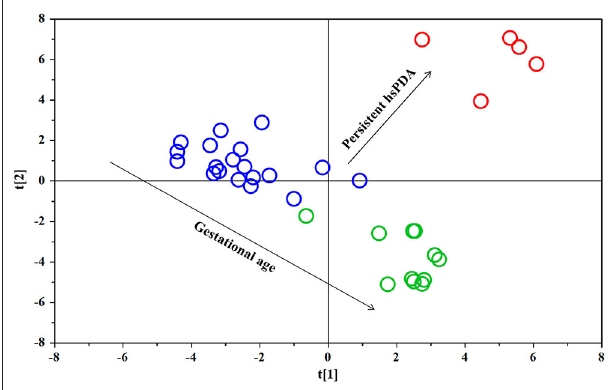
FIGURE 1 | PLS-DA scores plot of 1 H NMR spectra of urine samples: ≤ 30w No-hsPDA (blue circle), > 30w No-hsPDA (green circle) and ≤ 30w hsPDA (red